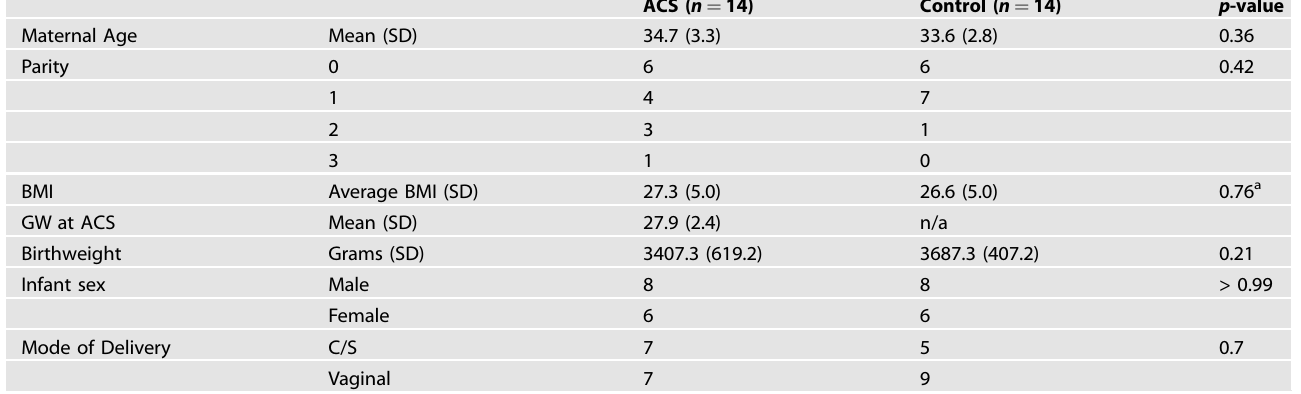
Table 1. Descriptive characteristics of study